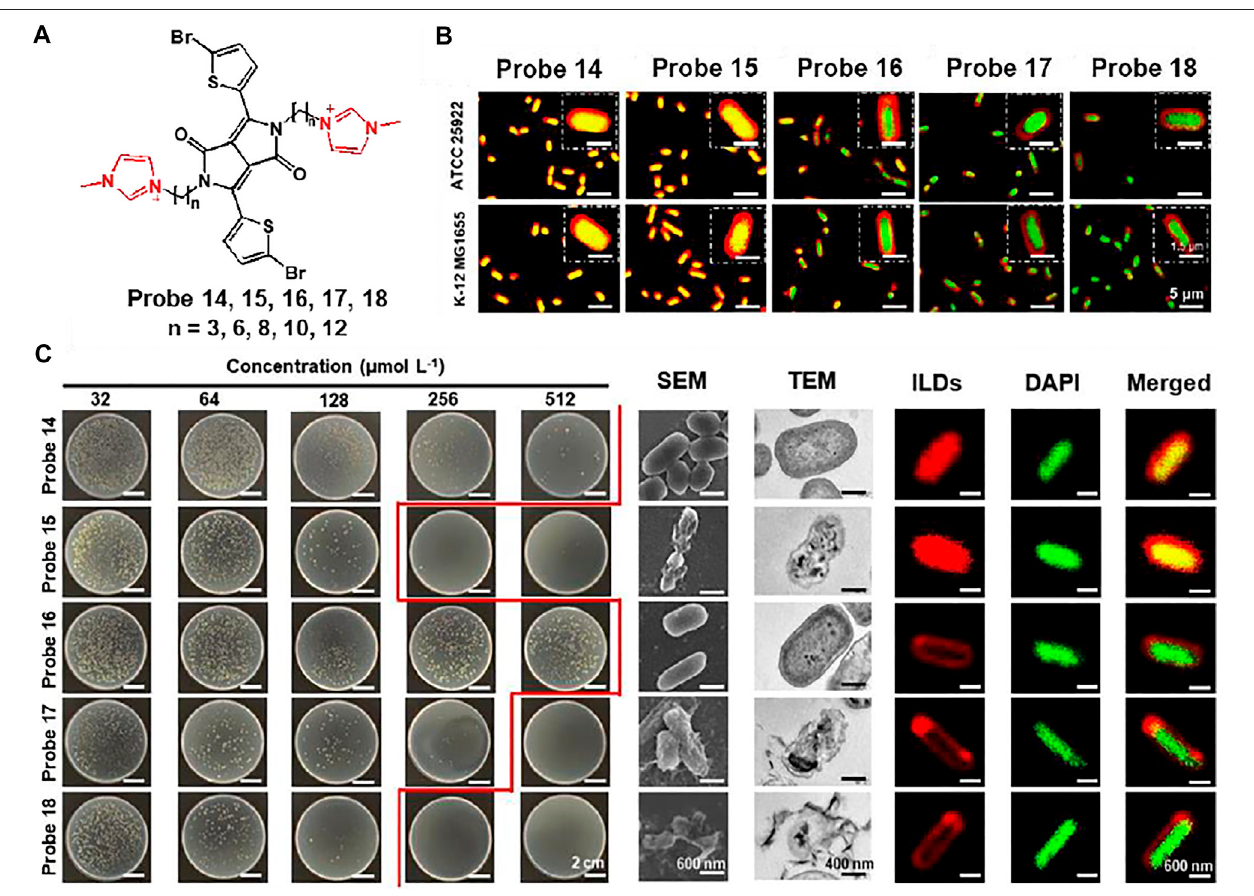
FIGURE 8 | (A) Chemical structures of probes 14 – 18. (B) Fluorescent localization of the interactions between probes and E. coli . (C) Colony of Gram-negative PAO1 incubated with various concentrations of probes, and their SEM, TEM, CLSM images. Reproduced with permission from Zheng et al. (2020). Copyright © 2020, American Chemical Society.